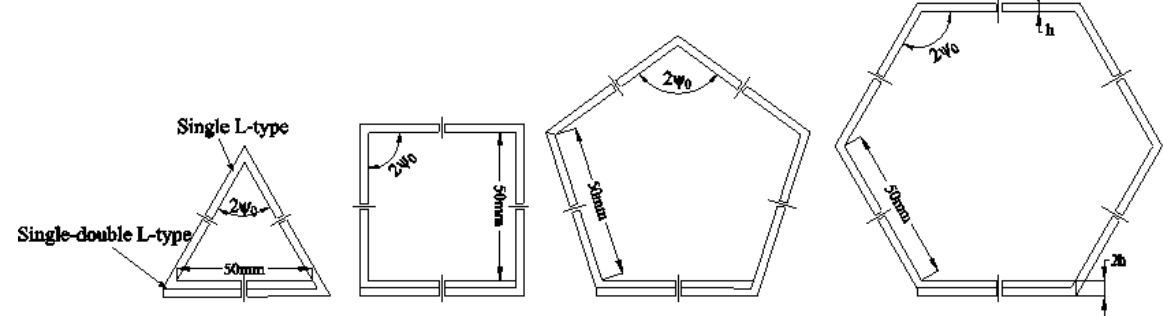
cylindrical surfaces, two sections of conical surfaces and a section of toroidal surface. The geometrical basic folding element is shown in Figure 8(b). In order to determinate the mean crush force required for the collapse of paper cor- rugation tubes under static loading, the energy method has been used. Neglecting the energy required for the partial breakage of full lapped adhesion, the energy dissipation is divided into three parts: (a) the extension of the toroidal shell, E 1 , (b) the forming of the horizontal plastic hinge lines, E 2 and (c) the forming of the inclined plastic hinge lines, E 3 .